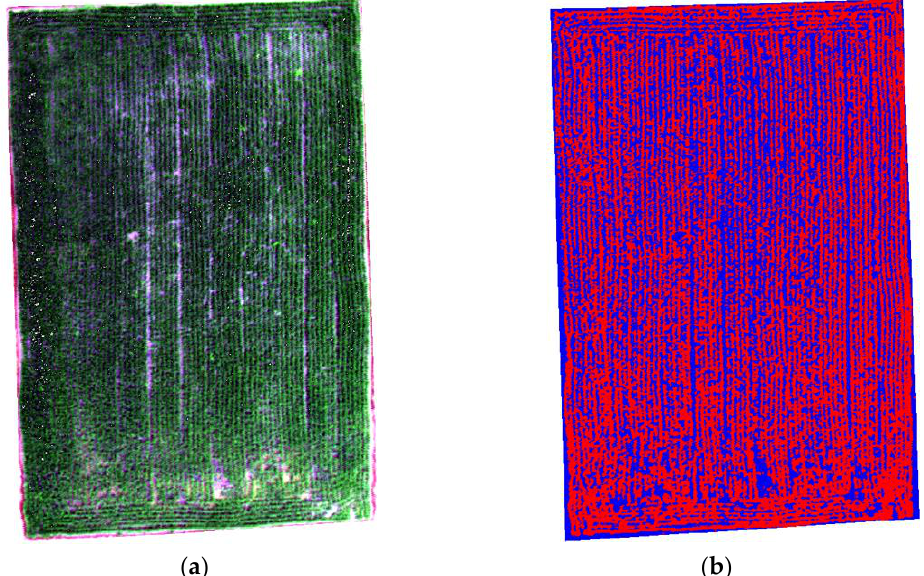
Figure 3. Terrestrial end-element hyperspectral images: ( a ) Original hyperspectral images; ( b ) Hyperspectral unmixing results.